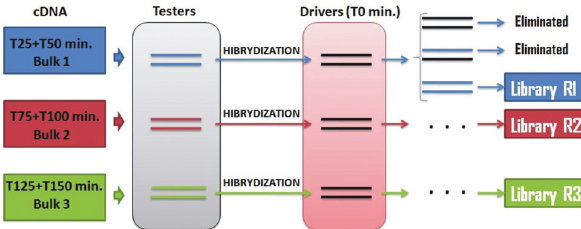
Figure 1 - Illustration of the subtracted libraries synthesis. cDNAs ex- tracted from drought-treated tissues were applied as tester and normalized using the control sample as driver. The subtractive effect occurred in the second hybridization cycle when an excess of driver was added to obtain transcripts expressed only in tester samples (forward subtraction). Li- braries were named as R/L1, R/L2 and R/L3 according to bulks 1 (25-50 min), 2 (75-100 min) and 3 (125-150 min),